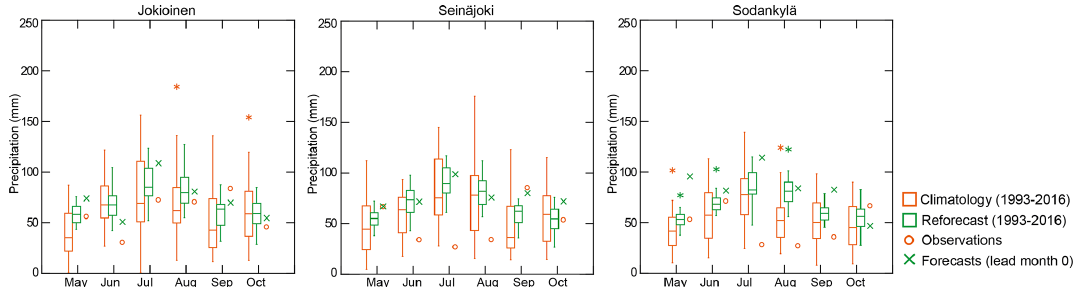
Figure 5. The forecasted and observed monthly precipitation sums for May–October 2019 and the climatology based on re-forecast precip- itation values and observations from 1993 to 2016 for the selected